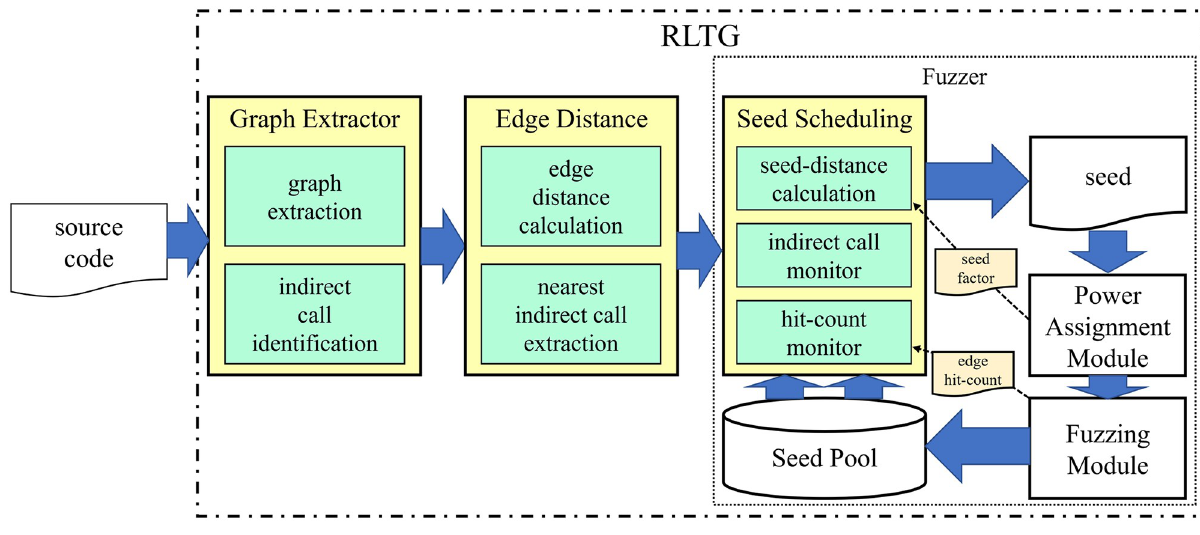
Fig 4. The architecture of